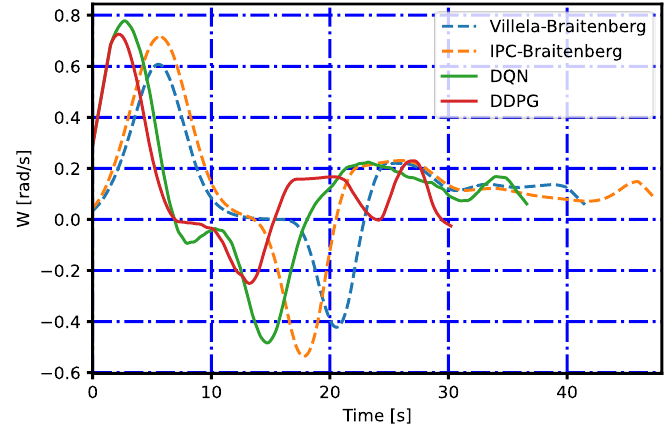
Figure 12. Angular velocity of the experiment with obstacles.